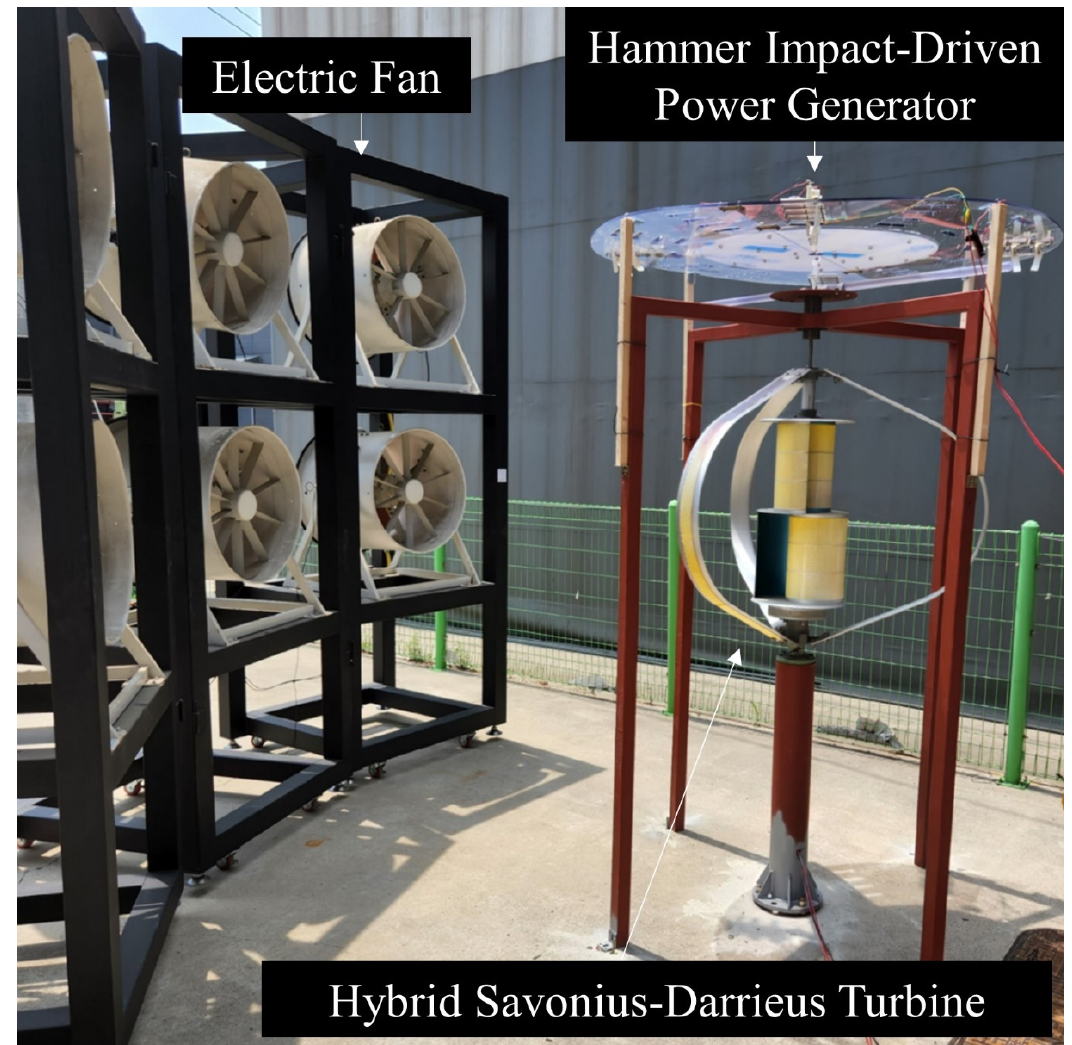
Figure 10. Photograph of hammer-impact-driven power generator using conventional hybrid Savonius–Darrieus turbine. Table 3. Summary of output performance of hammer-impact-driven power generator with various wind conditions.